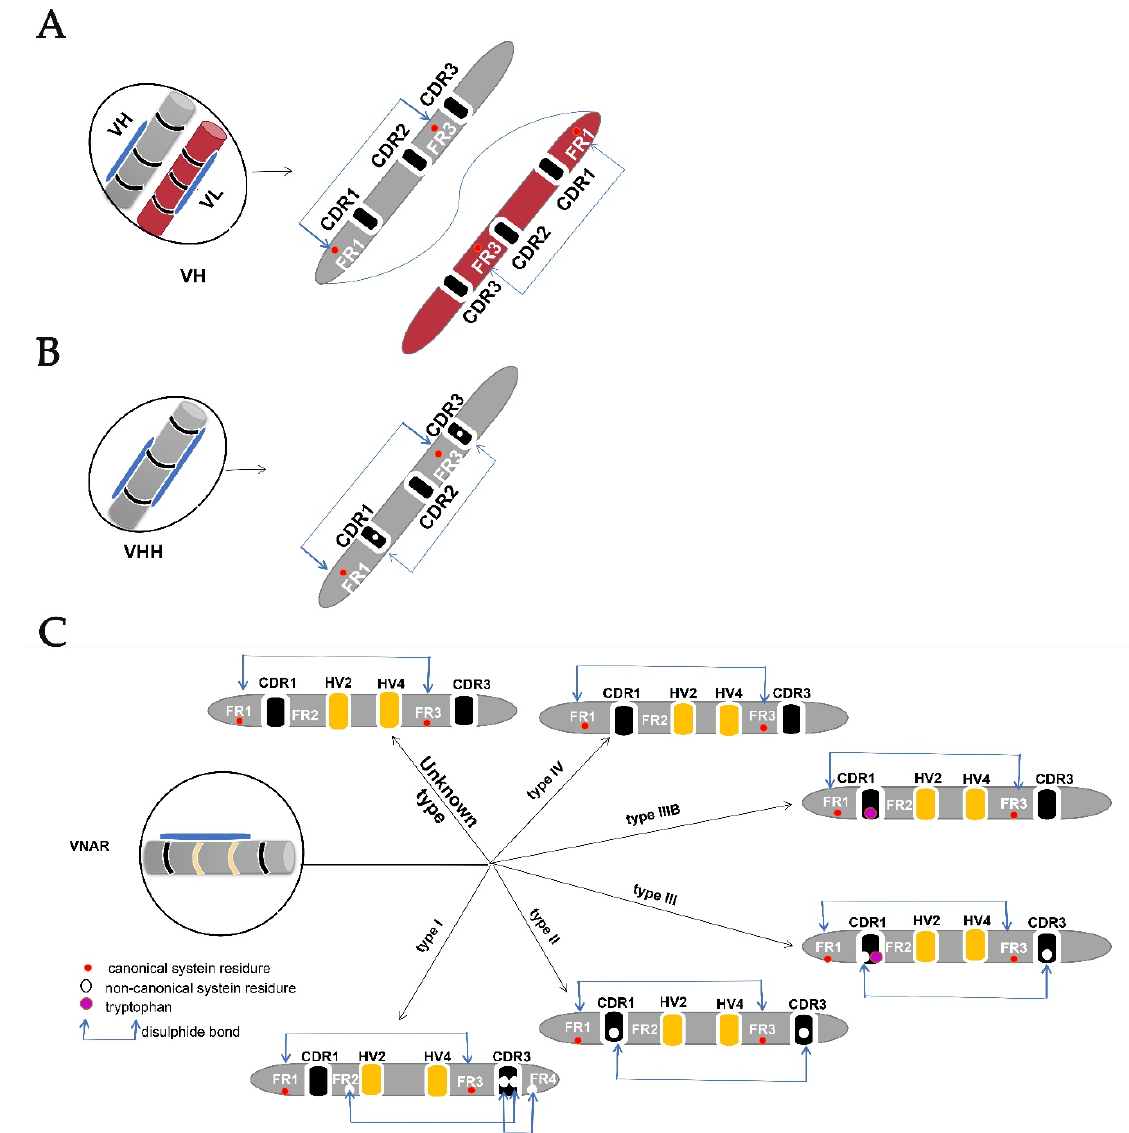
Figure 2. Variable domain structure. ( A ) IgG antibody variable domain (VH) with a disulfide bond connection be-tween the variable domain and two conserved canonical cysteine residues in the framework region (FR1) and (FR3). ( B ) HCAbs variable domain (VHH) with an extra cysteine residue forming a disulfide bond between CDR1 and CDR3 despite the conserved canonical cysteine residues. ( C ) Variable domain (VNAR) of IgNAR lacking a CDR2, with vari-ous numbers of noncanonical cysteine residues that give rise to different types of VNAR and hypervariable regions (HV2 and